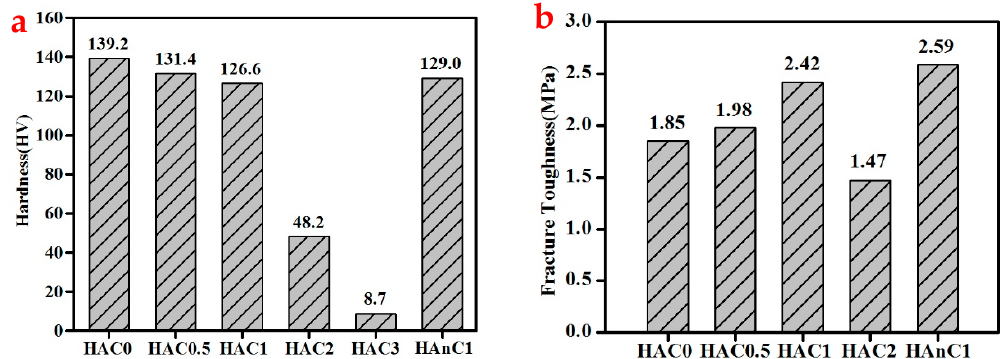
Figure 7. ( a ) Hardness and ( b ) fracture toughness of CNTs/HA and nHA–CNTs/HA composites.